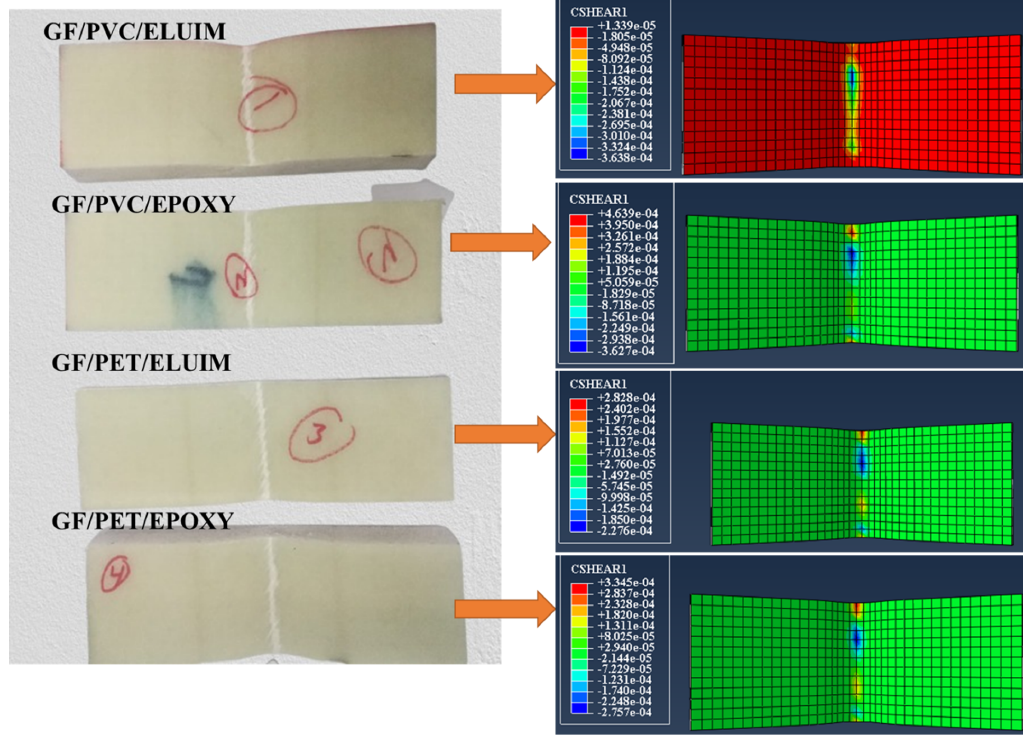
Figure 9. Experimental and simulation damage of the GFRP sandwich composites’ upper face sheets.